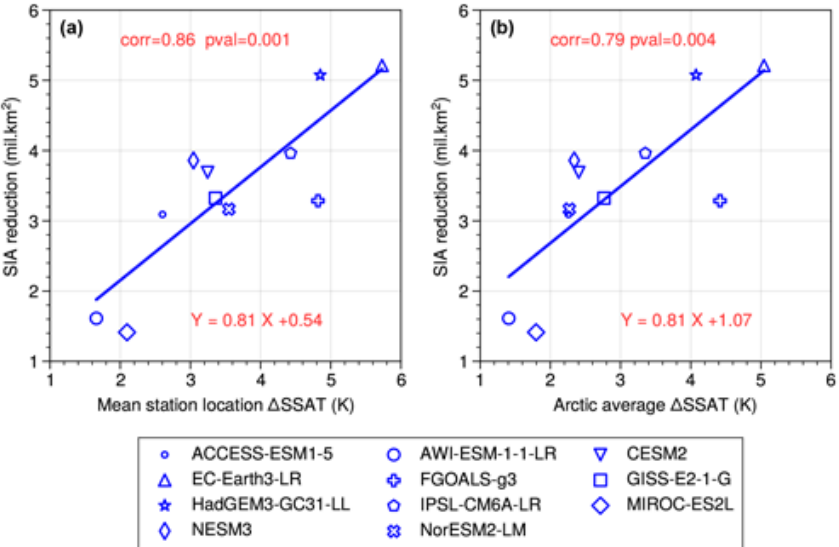
Figure 7. Modelled magnitude of (cid:49) SIA versus modelled (cid:49) SSAT for the Arctic. (a) The modelled (cid:49) SIA is scattered against mean modelled (cid:49) SSAT at the 21 data locations. (b) The modelled (cid:49) SIA is scattered against the mean modelled (cid:49) SSAT averaged over the Arctic north of 60 ◦